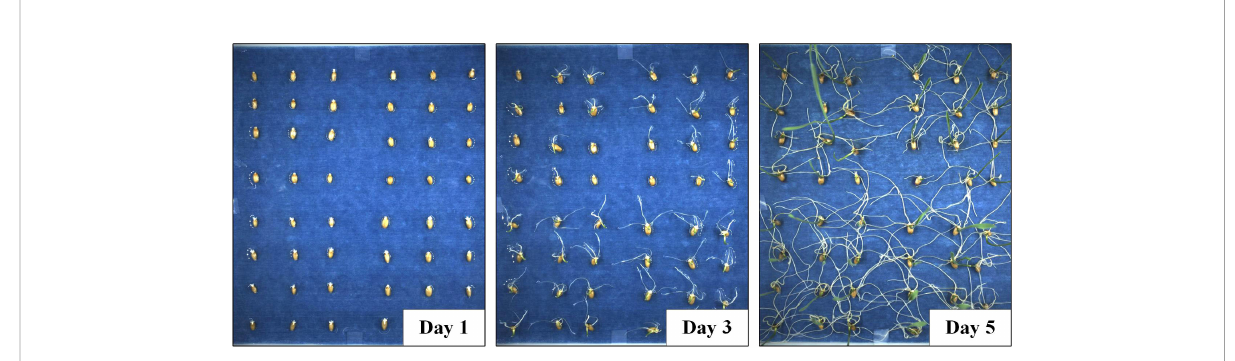
FIGURE 2 Continuous collection of growth images of wheat seeds during